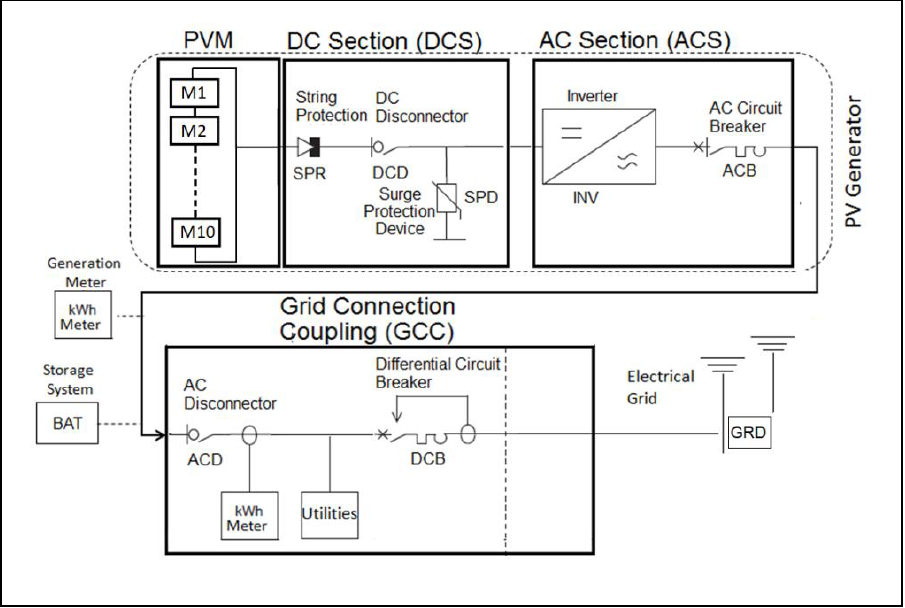
Figure 13. Schema of the deterministic process of the PV system, including the battery.